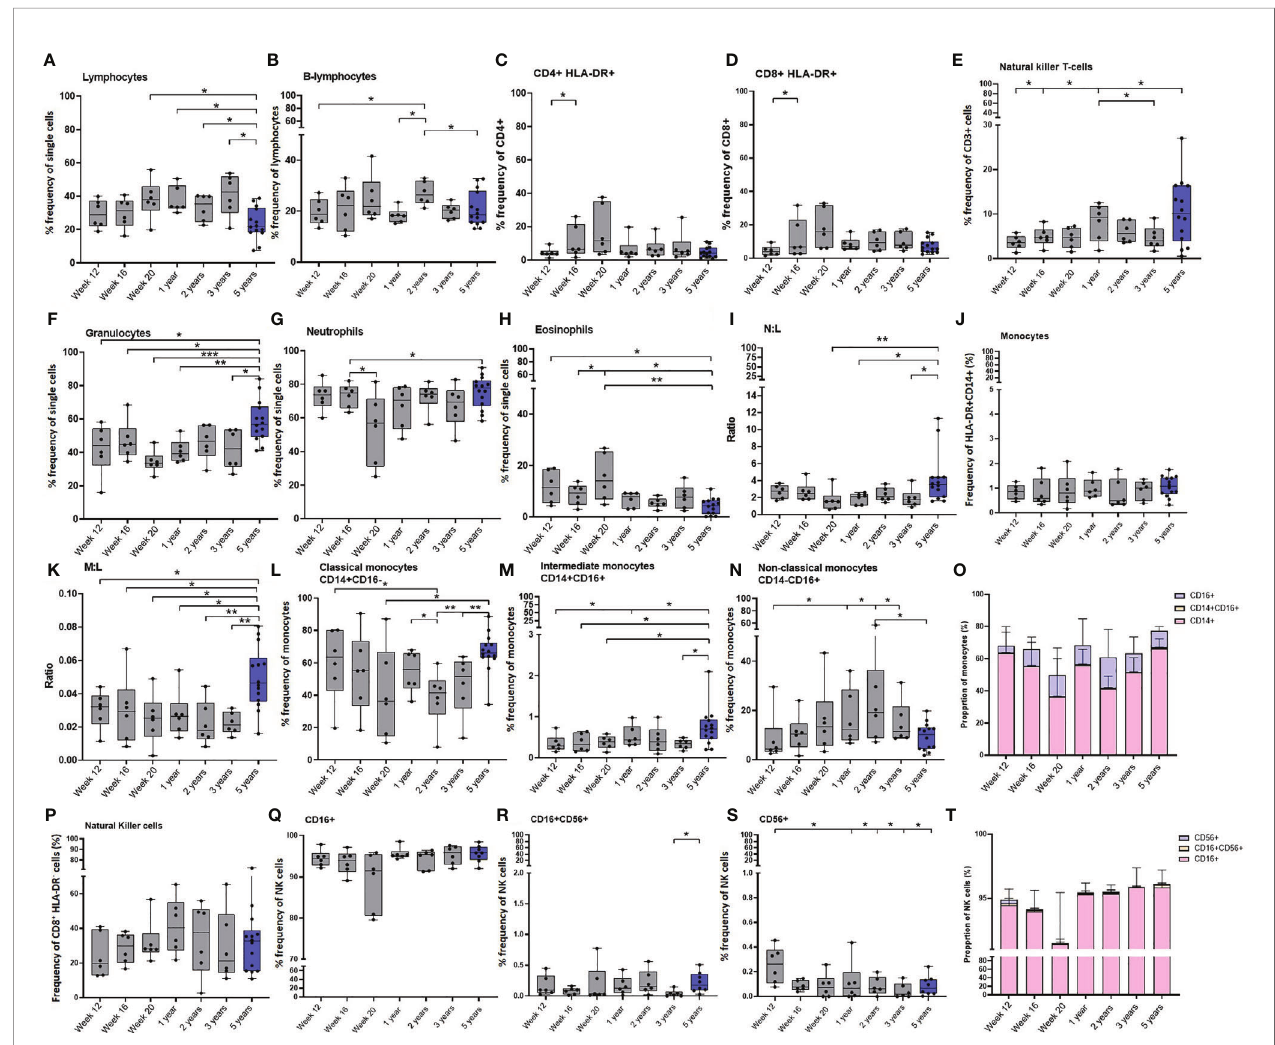
FIGURE 6 | Age related changes in white cell populations measured in whole blood. Plots show the frequency of (A) All lymphocytes, (B) B-cells, (C) activated CD4+ and (D) CD8+ T-cells, (E) NK T-cells, (F) Granulocytes, (G) Neutrophils, (H) Eosinophils, (I) Neutrophil: Lymphocyte (N:L) ratio, (J) All monocytes, (K) Monocyte: Lymphocyte (M:L) ratio, (L) Classical monocytes (M) Intermediate monocytes and (N) Non-classical monocytes. (O) Bars represent median values of monocyte subset populations. (P) Natural killer cells, (Q) CD16+ NK cells, (R) CD16+CD56+ NK cells, (S) CD16-CD56+ NK cells and (T) Bars represent median values of NK cell subsets. Cell frequency populations were measured in naïve macaques from infancy through to three years (grey) compared with young adult macaques aged 3.7 and 5.2 years of age (blue). Box plots show the group median +/- the inter-quartile range, with minimum and maximum values connected by whiskers. Signi fi cant differences measured by Wilcoxon matched-pairs rank test or Mann-Whitney U-test between the groups are indicated. *p ≤ 0.05, **p < 0.01, ***p <